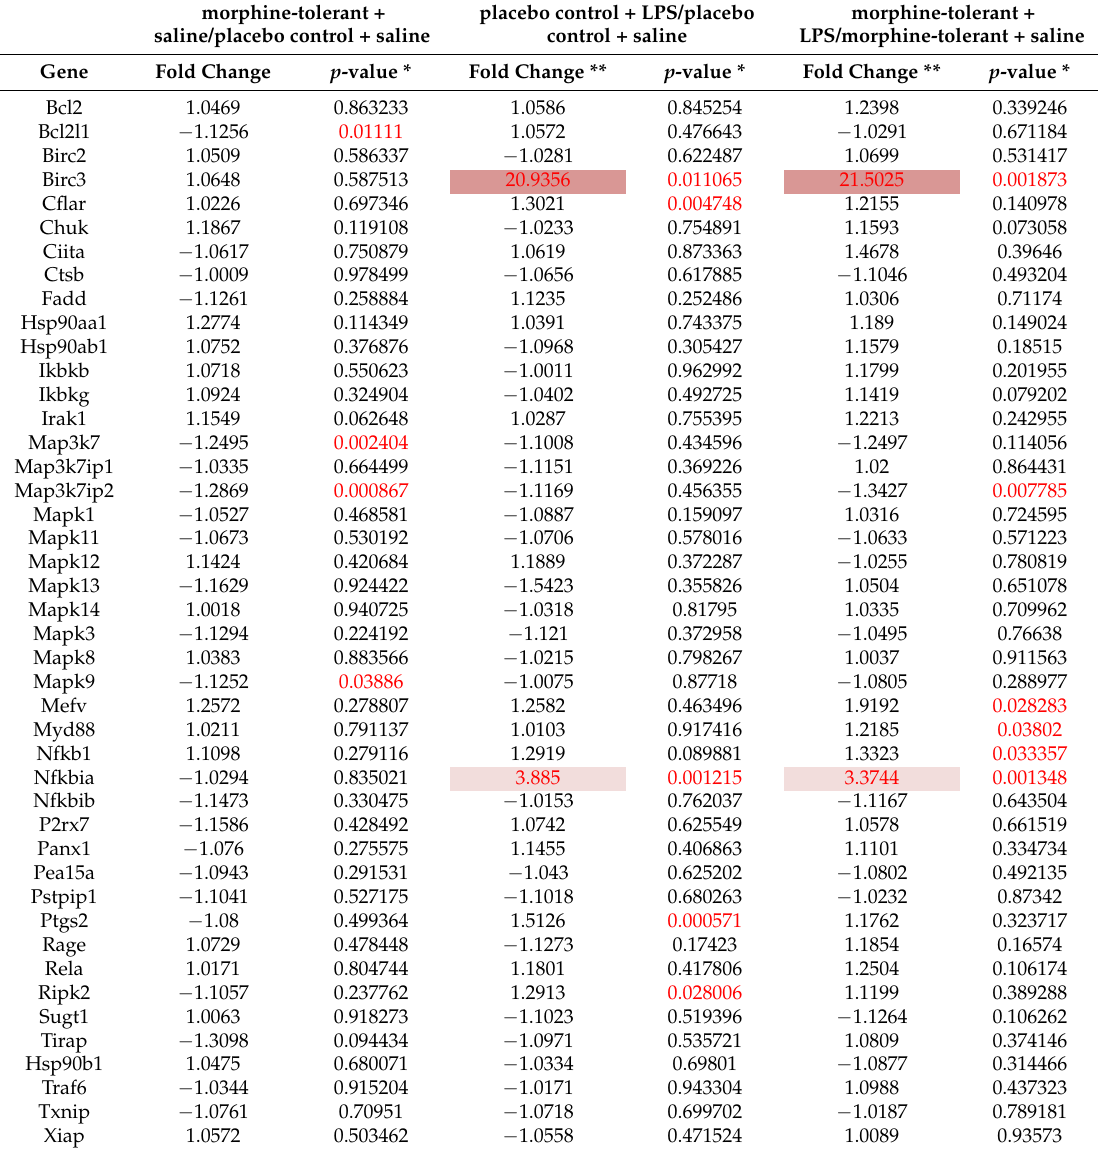
Table 2. Expression profile of inflammasome-related downstream signaling genes in the rat brain in response to lipopolysaccharides (LPS), with and without morphine tolerance. Full name of the genes were provided in Table A1.